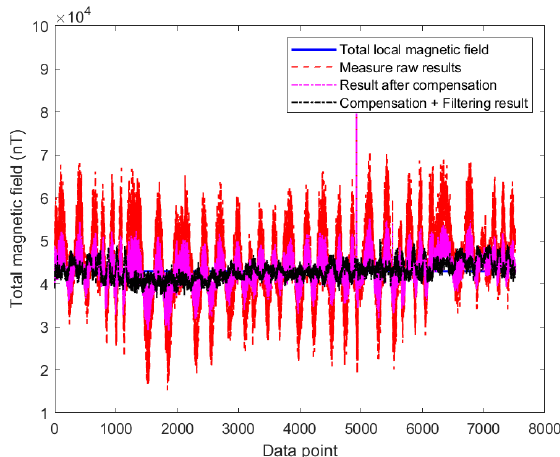
Figure 11. Data comparison before and after filtering.